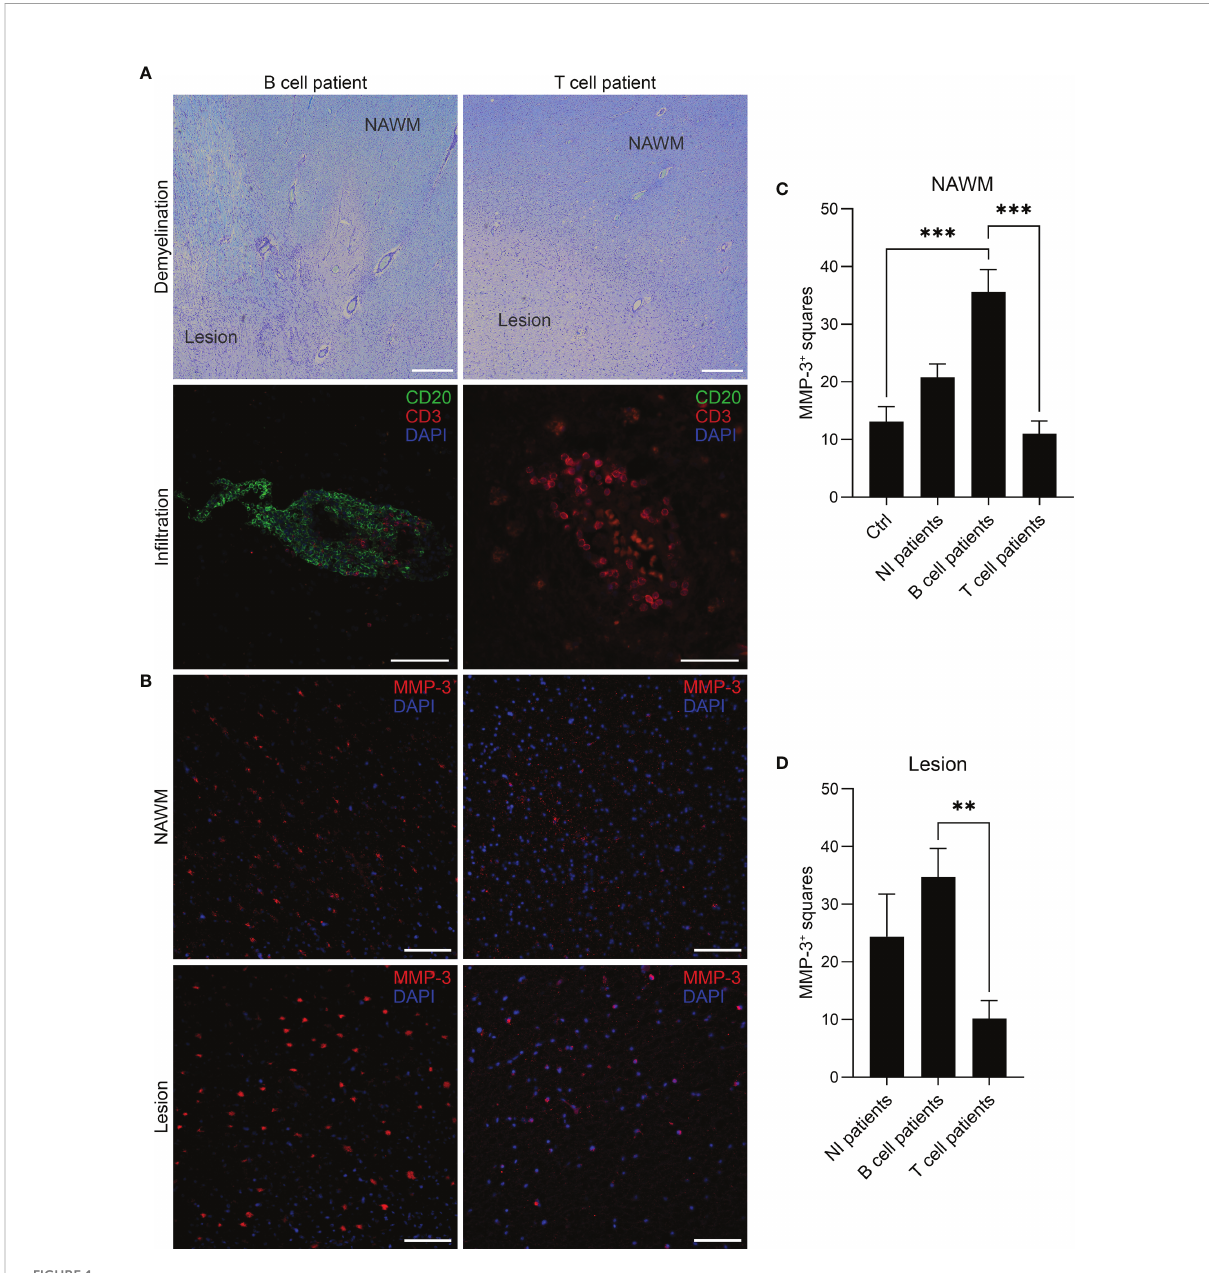
FIGURE 1 MMP-3 expression in MS brain tissue of different patient groups. (A) Representative images of a patient in the “ B cell ” and “ T cell ” group. Lesions and NAWM were determined by visualizing demyelinated and myelinated areas based on a Klüver-Barrera staining. Scale bars represent 500 µm. The B cell patient was characterized by the presence of both CD20 + B cells and CD3 + T cells, while the T cell patient showed in fi ltration of CD3 + T cells only. Scale bars represent 100 µm and 50 µm, respectively. (B) The images show MMP-3 expression in the same B cell and T cell patient (as shown in A) comparing lesion and NAWM. Scale bars represent 50 µm. (C, D) Quanti fi cation of MMP-3 expression in (C) NAWM and (D) lesion in different patient groups. The graph shows the number of squares containing MMP3 + cells by using an overlying grid. Bar graphs represent mean values + SEM. ** p < 0.01, and *** p < 0.001; one-way ANOVA. NAWM, normal appearing white matter; NI, no CD3/CD20 in fi